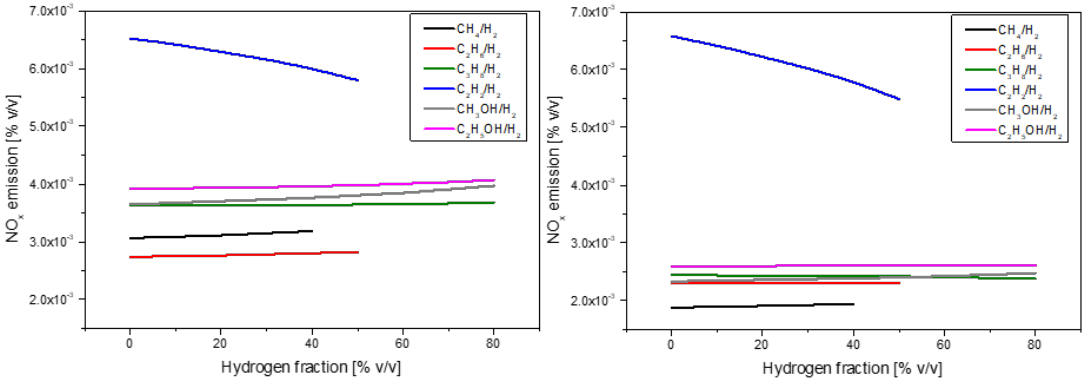
Figure6. TheimpactofhydrogenfractiononNO X atlean( Left )andstoichiometry( Right Figure 6. The impact of hydrogen fraction on NO X at lean ( left ) and stoichiometry ( right ) compositions .